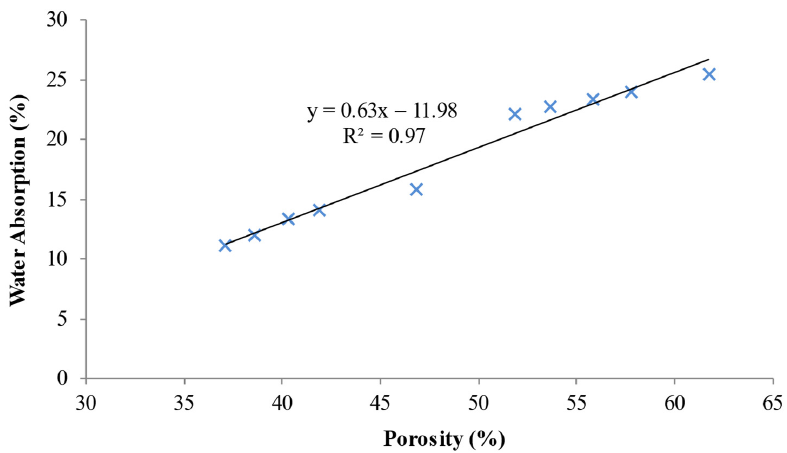
Figure 12. Correlation between the water absorption and porosity of LFC.